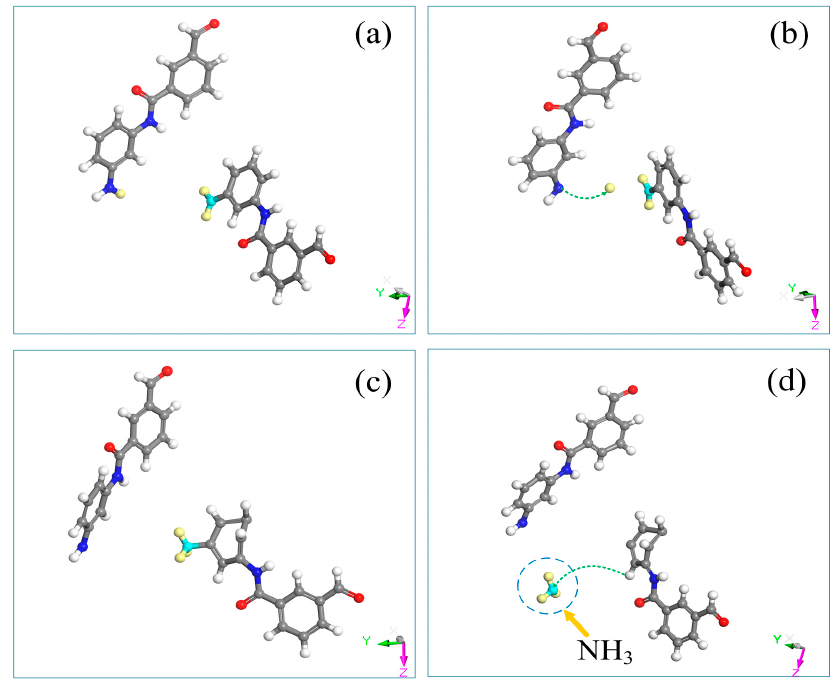
Polymers 2018 , 10 , x FOR PEER REVIEW 10 of 13 Figure 9. Generation path snapshots of the NH 3 micromolecule for decomposition at 2000 K: ( a ) 1 ps, ( b ) 21.8 ps, ( c ) 40.9 ps, ( d ) 41.2 ps.